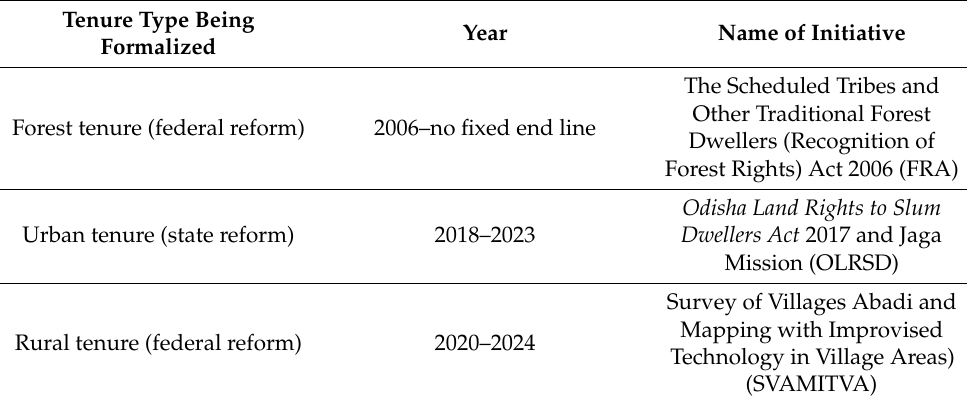
Table 1. Overview of Indian land formalization